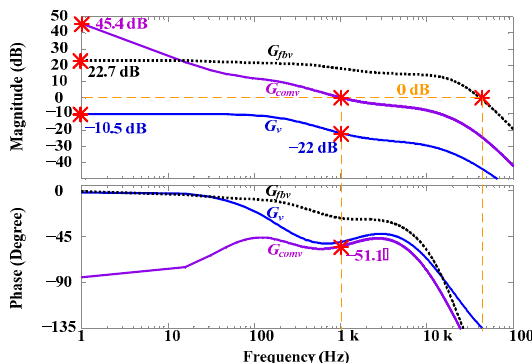
Figure 13. Bode plot simulations: G v ( s ), G comv ( s ), and G fbv ( s ).